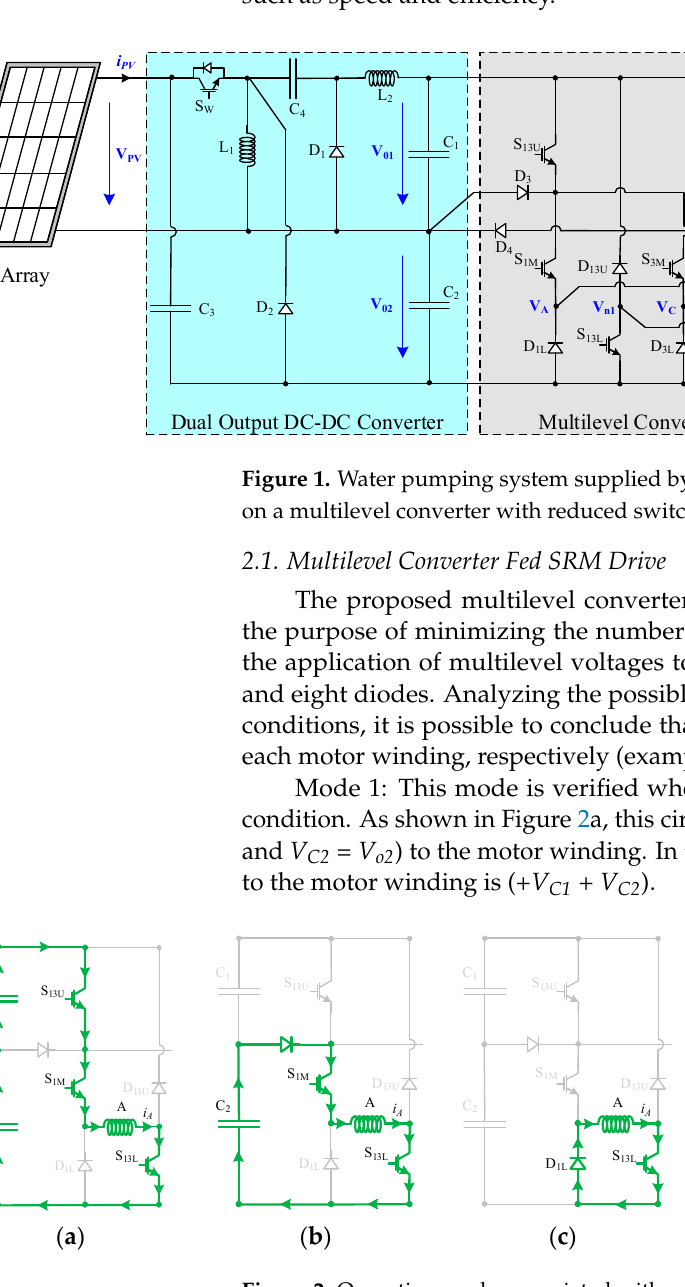
Figure 2. Operating modes associated with each motor winding: ( a ) Mode 1 → +V C1 +V C2 , ( b ) Mode 2 → +V C2 , ( c ) Mode 3 → 0, ( d ) Mode 4 → − V C1 , ( e ) Mode 5 → − V C1 − V C2 .